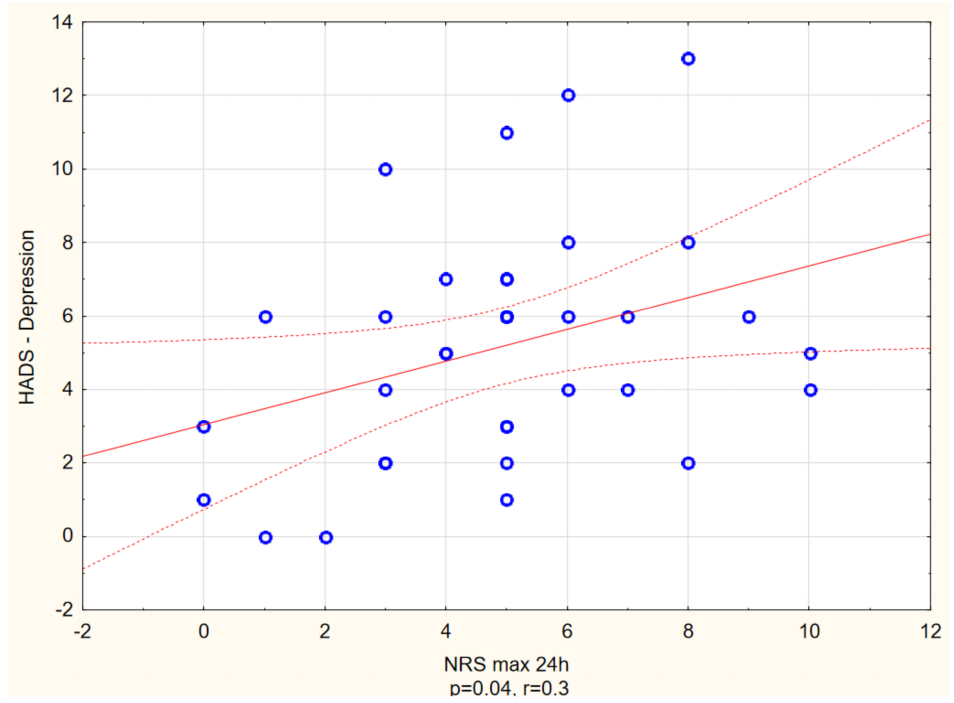
Figure 5. Spearman’s correlation analysis revealed a significant positive link between maximal itch intensity measured with Numerical Rating Scale (NRS) and possibility of clinically relevant depression measured with Hospital Anxiety and Depression Scale (HADS) (R = 0.3, p = 0.04). Sex, age, BMI, duration of the disease did not correlate with any of the dependencies in the utilized